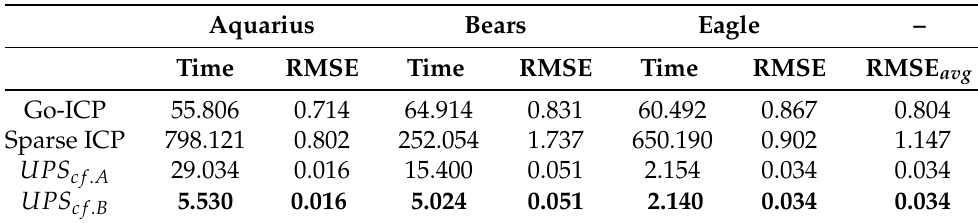
Table 5. Elapsed time (in seconds) and RMSE (in meters) of the registration under conditions of rotation on arbitrary axes. Aquarius Bears Eagle